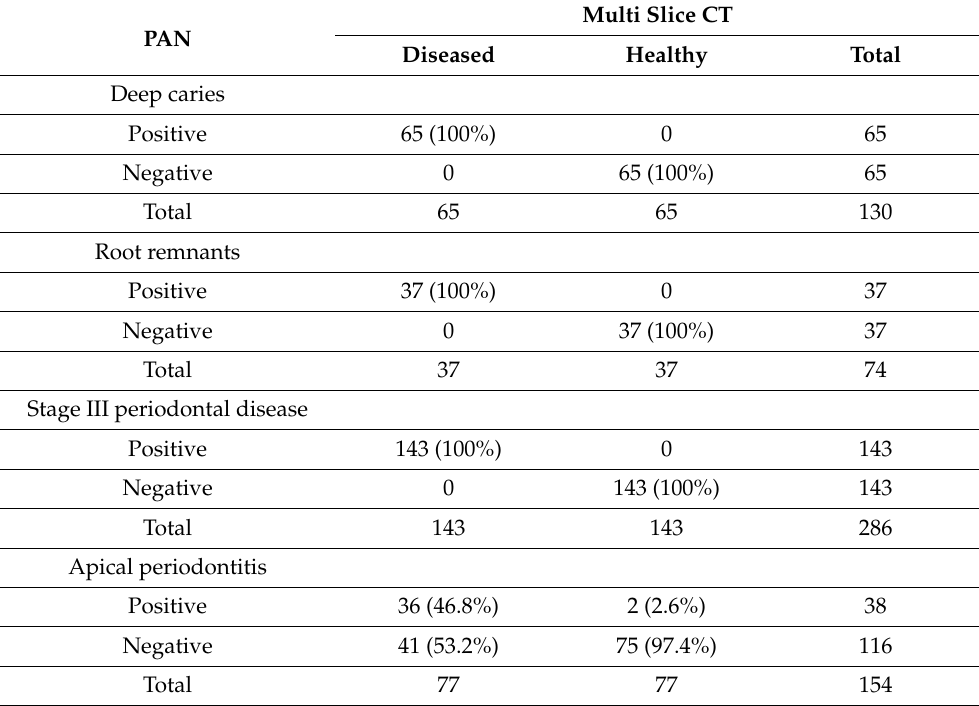
Table 1. True Positives, False Positives, True Negatives, and False Negatives for Panoramic Radiogra- phy (PAN) in Relation to Multislice Spiral Computed Tomography (MSCT).